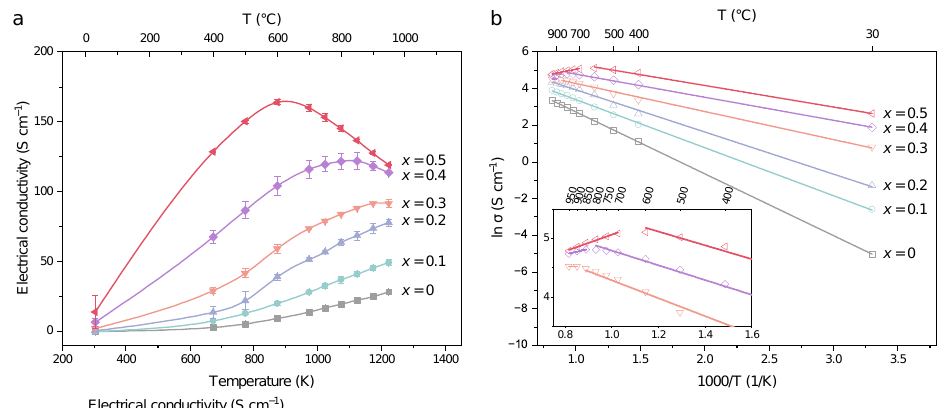
Figure 6. ( a ) Temperature-dependent electrical conductivity of Pr 1– x Sr x (Cr,Mn,Fe,Co,Ni)O 3– δ ( x = 0–0.5) membranes and ( b ) its Arrhenius plot.